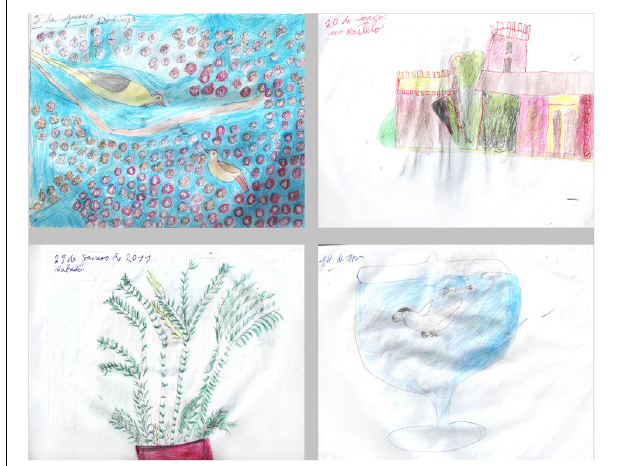
FIGURE 2 | Drawings with higher and lower CAT scores. Left panel: drawings with the highest global scores (8.5 for the upper drawing, range 4–10; 7.4 for the lower drawing, range 3–10). Right panel: drawings with the lowest global scores (5.8 for the upper drawing, range 4–10; 6.0 for the lower drawing, range